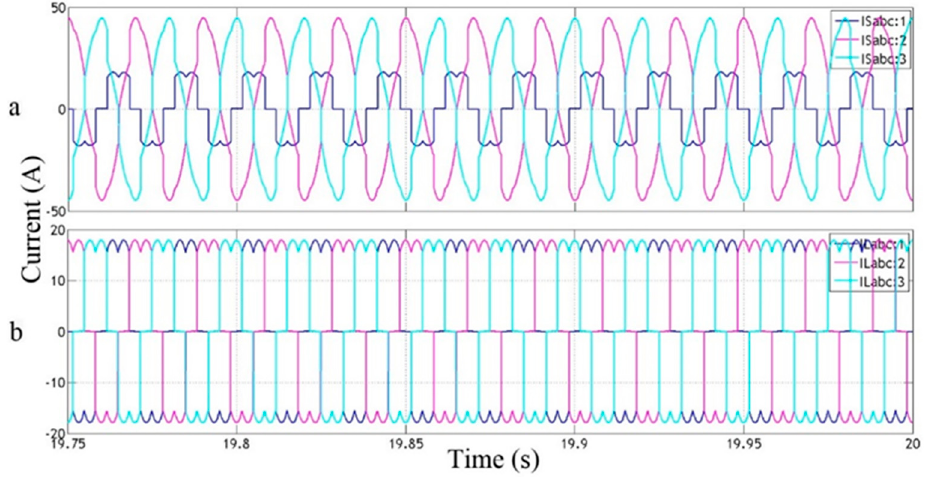
Figure 18. Before compensation unbalanced system ( a ) source current; ( b ) load current.